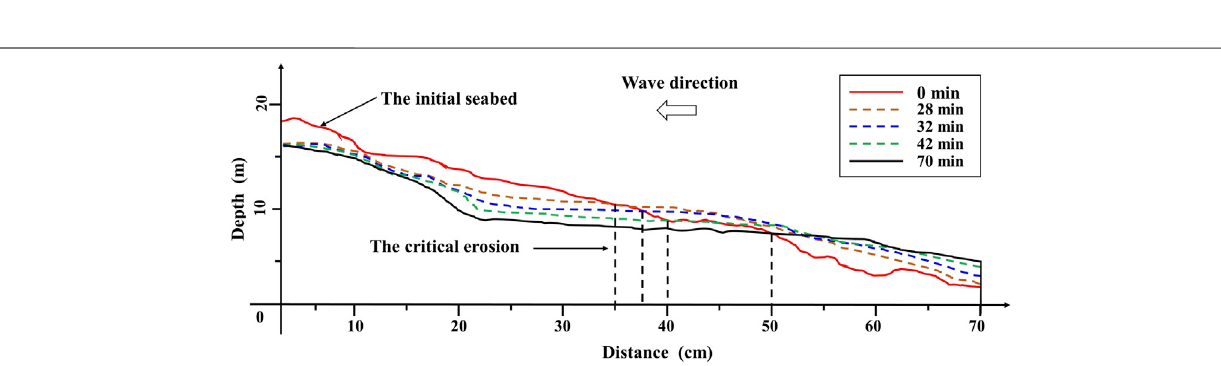
FIGURE 9 | Evolution of the surface morphology of the sediment seabed with time.